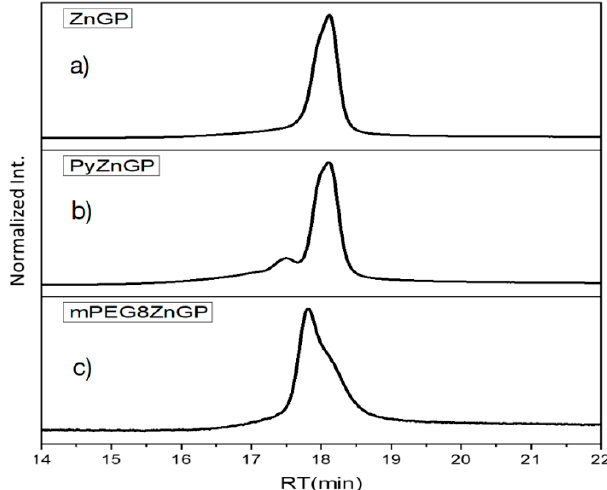
Figure 15. GPC charts of reorganized ( a ) GP1 , ( b ) PY-GP1 , and ( c ) PEG8-GP1 . (column; TOSOH TSKgel G4000H HR × 2 (exclusion limit; 400,000 Da), eluent; CHCl 3 :THF = 95:5, flow rate; 1.0 mL / min, detection; 565 nm).